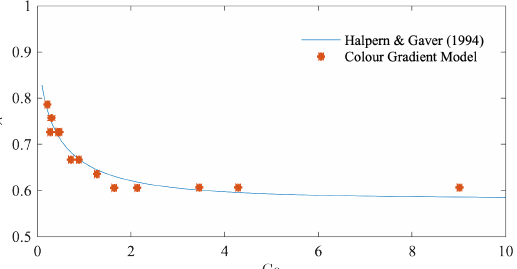
Figure 4. Finger width as a function of capillary number. Our simulation results from the colour gradient model are shown as stars in comparison with the results from Halpern [40] shown as a solid